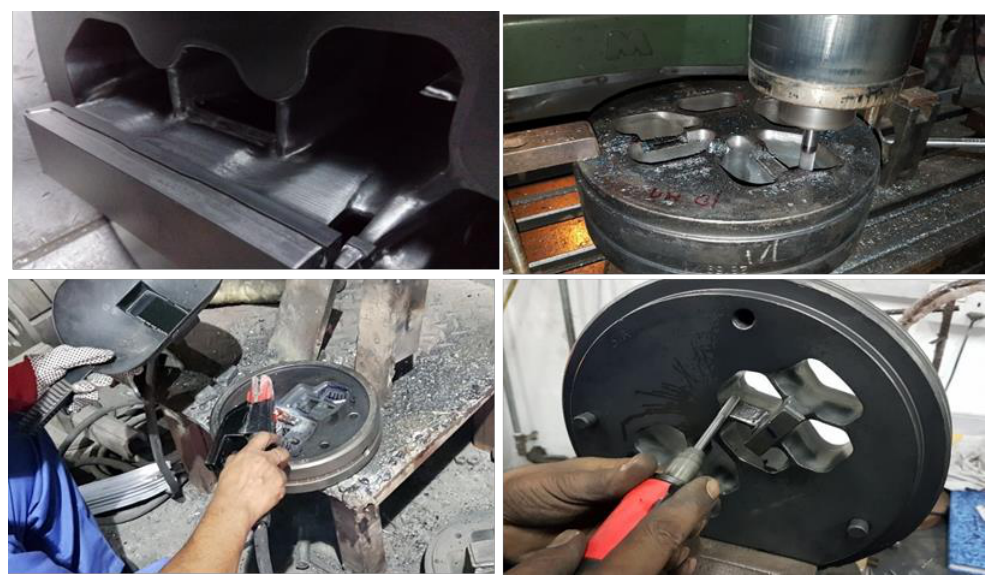
Figure 8. Some die correction operations: undercutting ( top left ); milling ( top right ); welding ( bottom left ); grinding ( bottom right ).